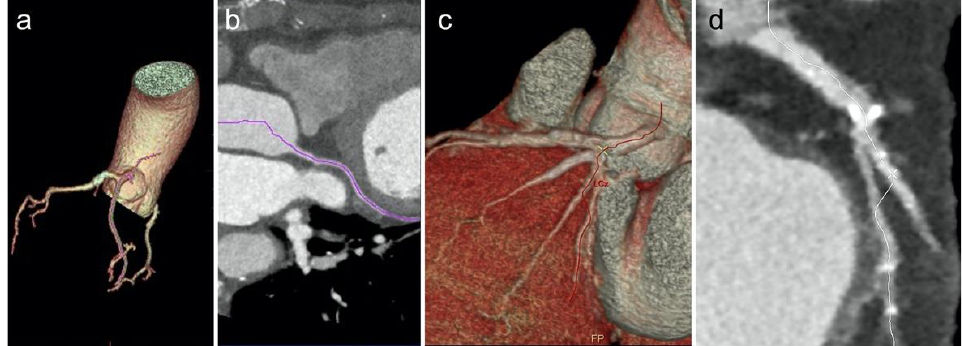
Figure 4. Software 1 showing a VR model ( a ) and a cMPR ( b ) of a correctly identified LCx. Software 2 ( c , d ) provides an inaccurate vessel identification, tracking part of the first obtuse marginal artery in lieu of the proximal LCx.